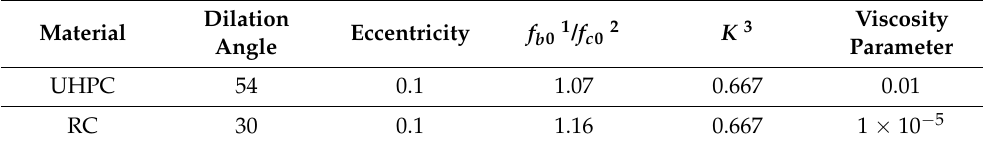
Table 3. Parameters of constitutive models used for UHPC and RC. Dilation Material Angle